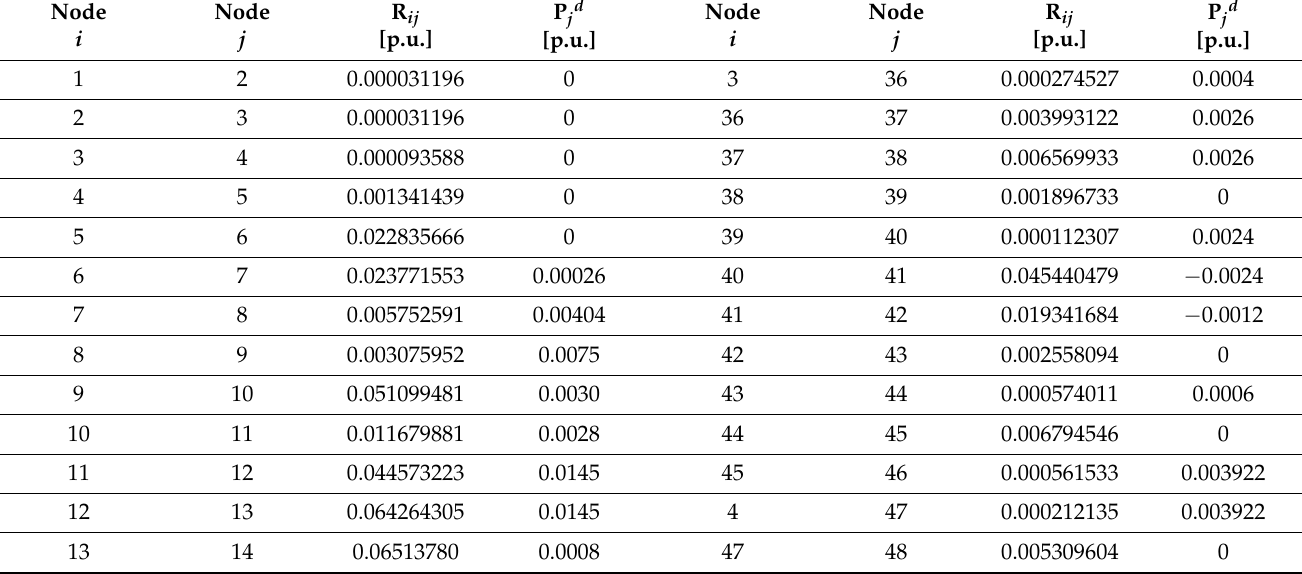
Table A2. Parameters of the 69-node test